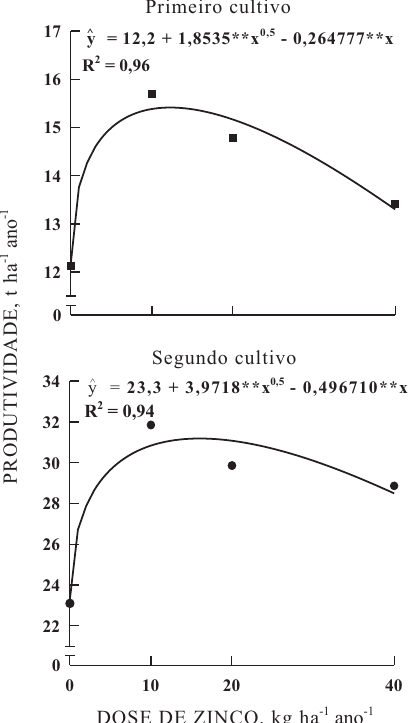
Figura 1. Produtividade de frutos de banana “Prata Anã” irrigada em função de doses de zinco, via solo, em dois cultivos. (**significativo a 1 % pelo teste de